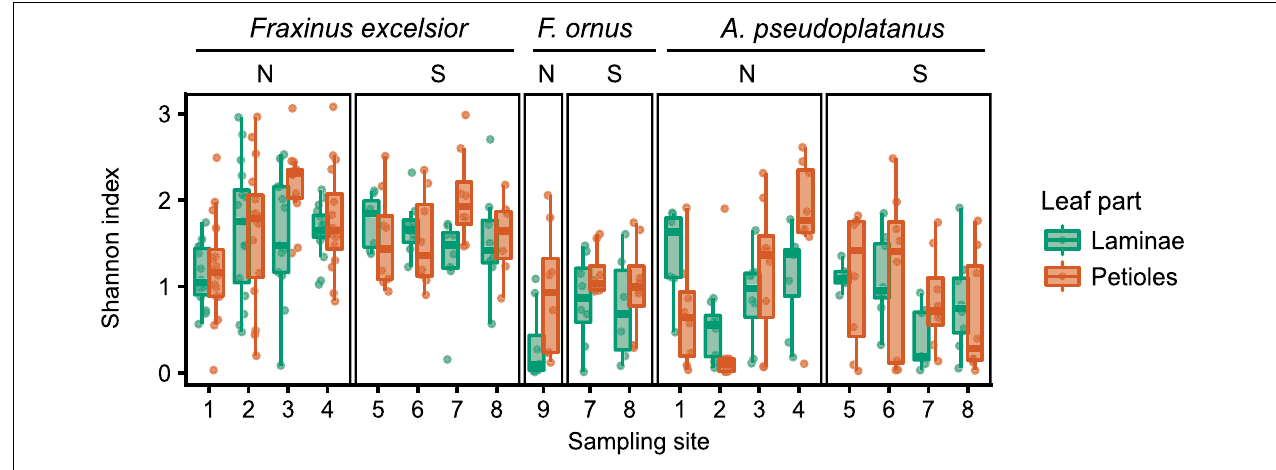
FIGURE 3 | Variability of the Shannon alpha diversity measure, summarized per sampling site for all host species and both leaf parts (green, laminae; orange, petioles). The overlaid points represent individual tree samples. The sites are grouped into the north (N) and south (S) side of the Alps. “Site” 9 collectively refers to all planted trees sampled on the north side of the Alps.